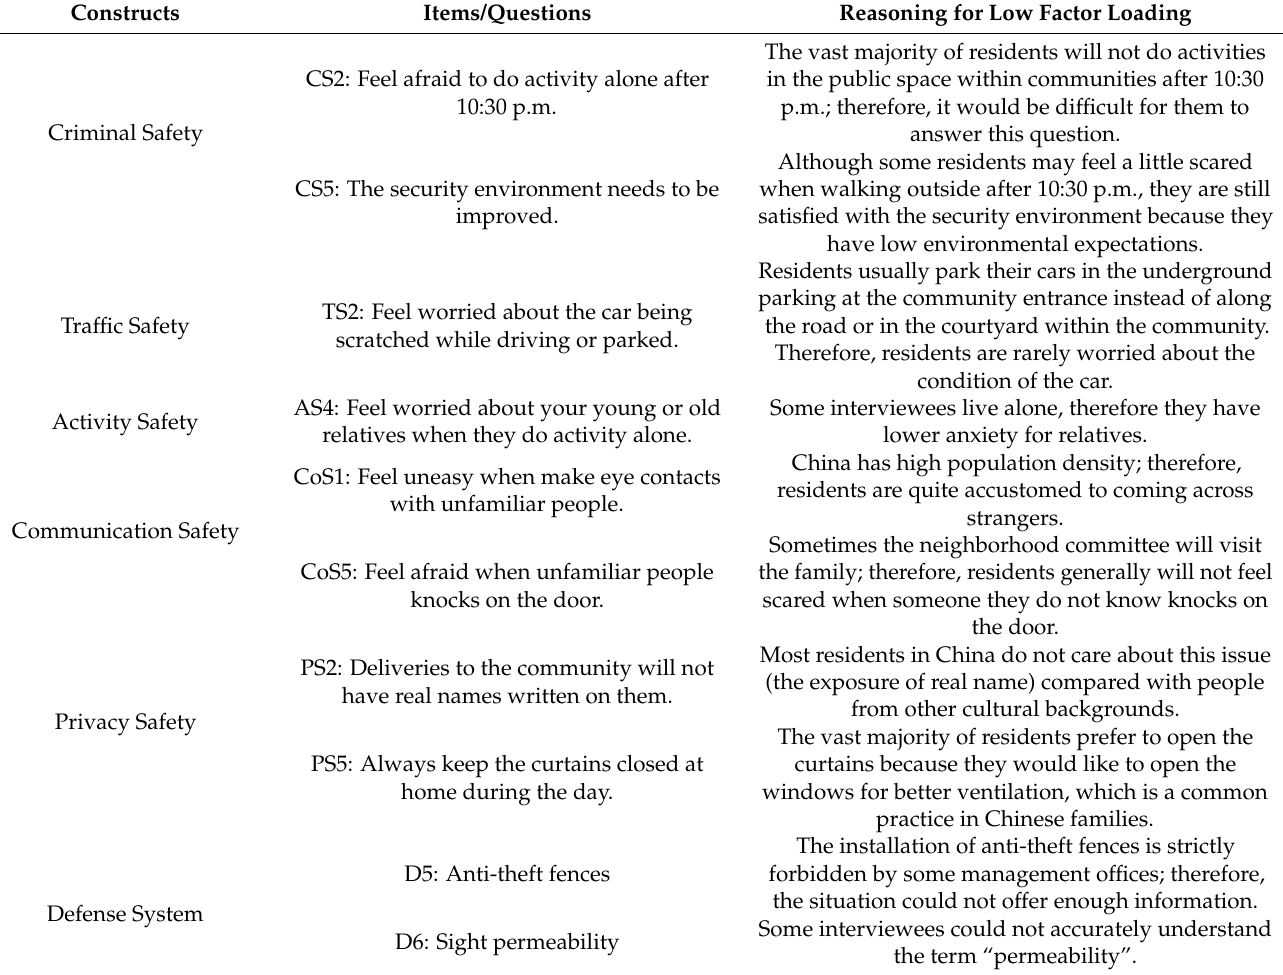
Table A2. Deleted Items and Possible